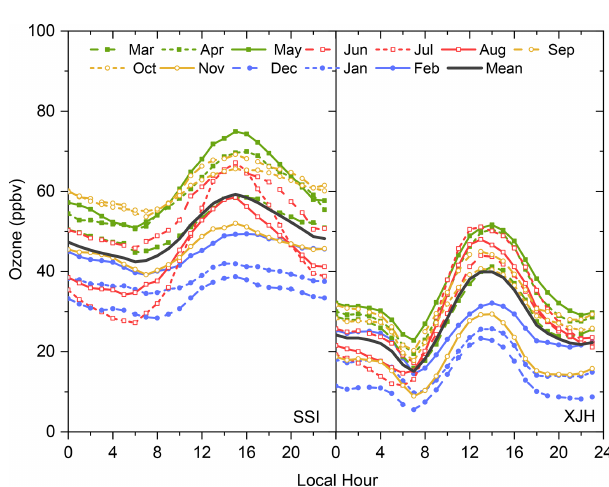
Figure 4. Monthly and year-round mean diurnal variations of O 3 (ppbv) at the Sheshan Island (SSI, remote and oceanic) and Xujiahui (XJH, urban) sites from 2012 to